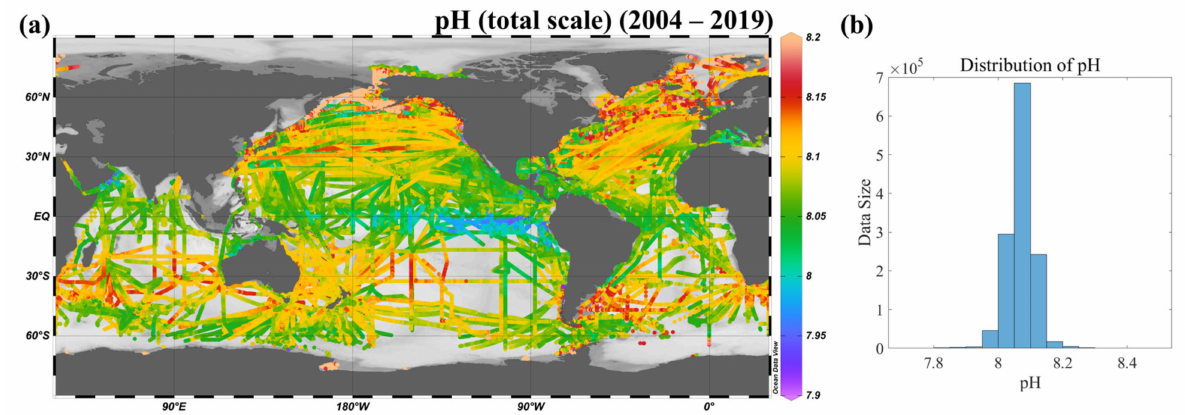
Figure 5. ( a ) Spatial distribution of the global pH dataset calculated from the in situ p CO 2 and the calculated TA. ( b ) Histogram of the pH